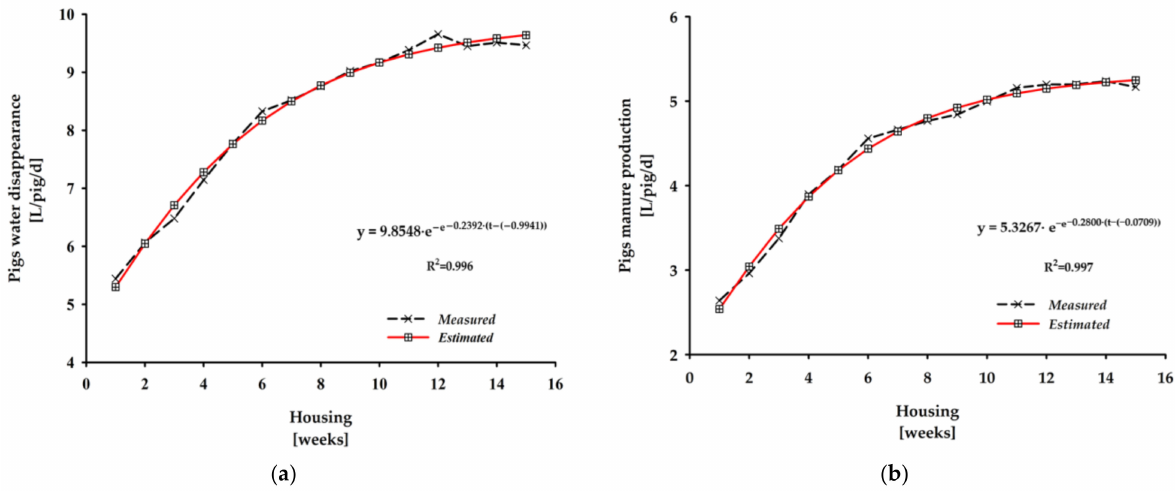
Figure 1. Adjustment of the non-linear Gompertz model to the weekly means data con- sidering the pigs’ housing period for the growing–finishing phase: ( a ) Water disappearance; ( b ) Manure